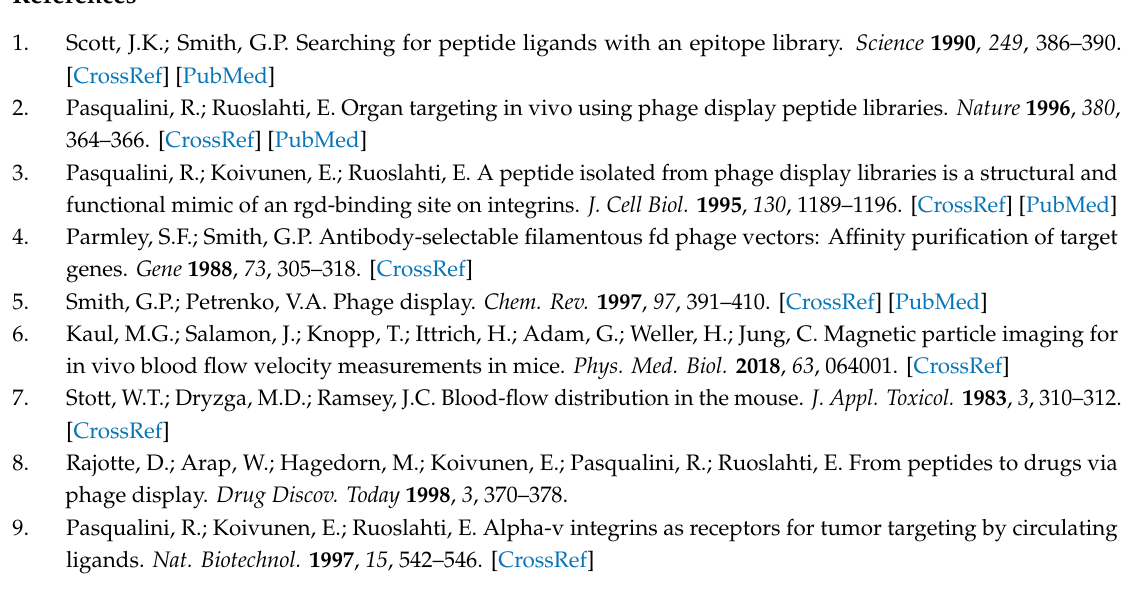
Figure S1: Quantification of phages in mouse tissues (medium dose); Figure S2: Comparison of tissue-selective motif normalization strategy; Table S1: Filamentous phage library